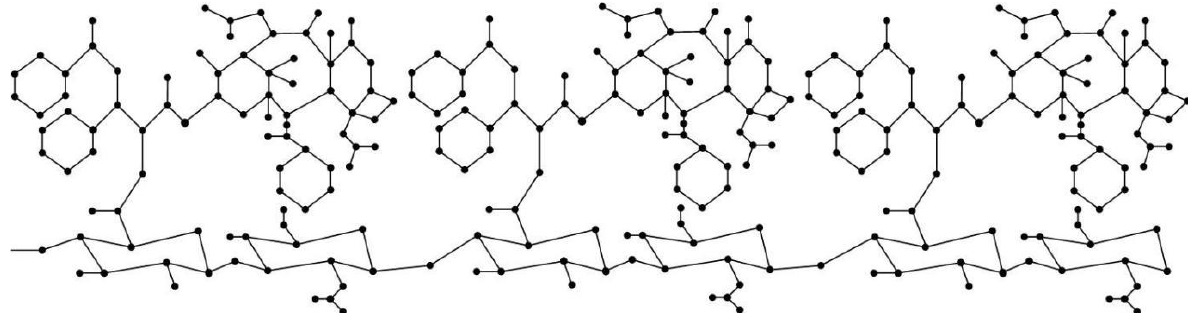
Figure 3: Corresponding molecular graph G